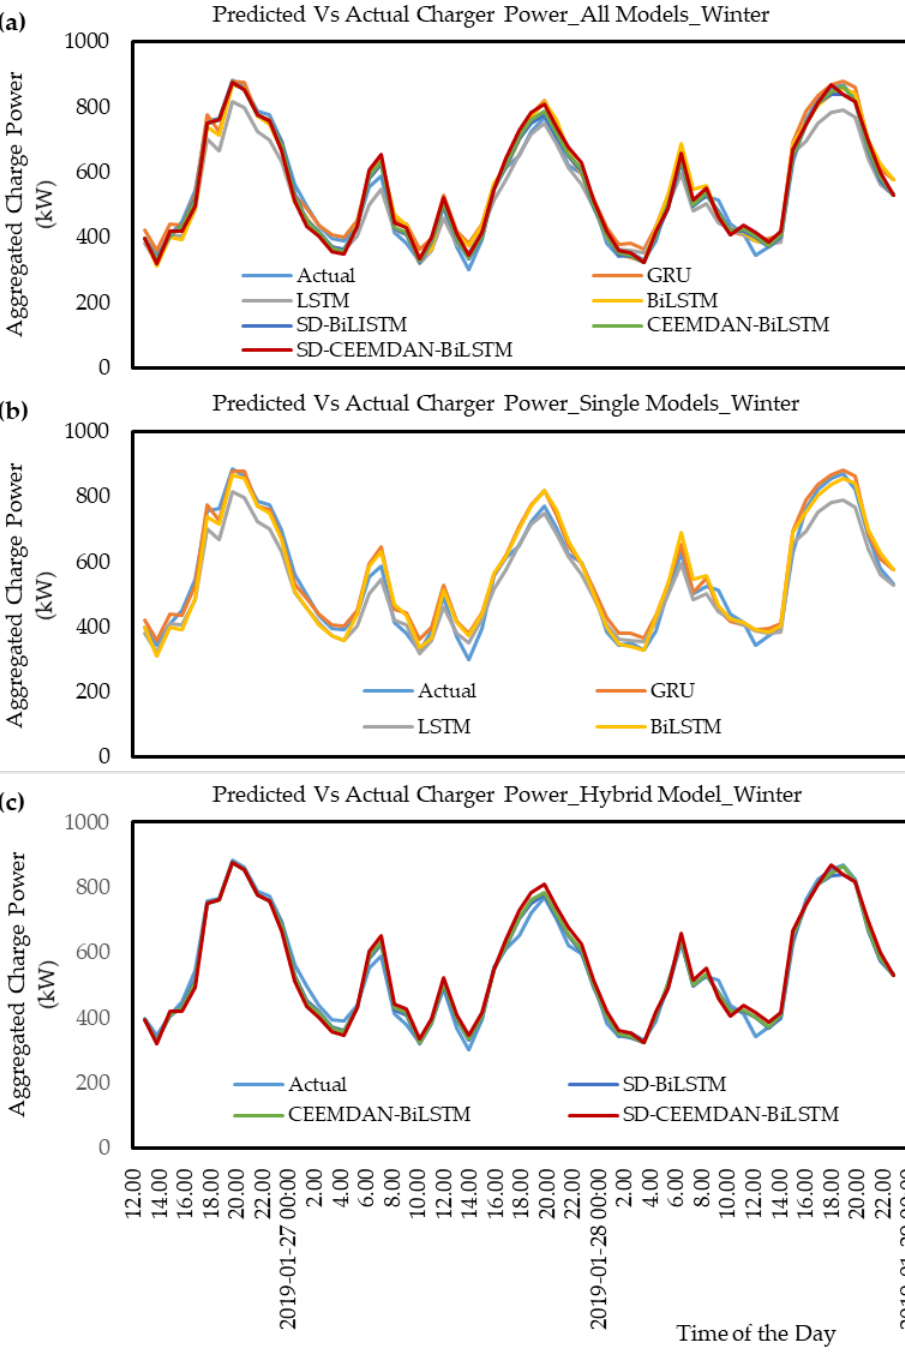
Figure 8. Predictions and actual aggregated charge power during the three-day-ahead prediction period in winter for ( a ) all prediction models, ( b ) single prediction model, ( c ) hybrid prediction model.